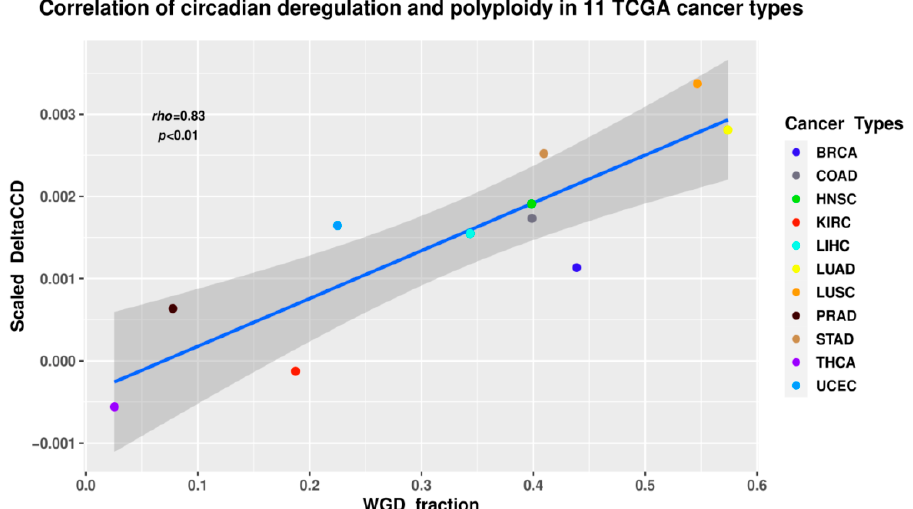
Figure 10. The DeltaCCD (clock correlation distance) coefficient (calculated using the method developed by [55]) describes the extent to which the core clock gene coexpression network diverges from its normal state. The tumor types with a higher prevalence of polyploid (WGD+) samples also demonstrate more profound CC deregulation (Spearman’s rho = 0.83, p < 0.01) and high disease aggressiveness: BRCA—breast carcinoma; COAD—colon adenocarcinoma; HNSC—head and neck squamous cell carcinoma; KIRC—kidney renal cell carcinoma; LIHC—liver hepatocellular carcinoma; LUAD—lung adenocarcinoma; LUSC—lung squamous cell carcinoma; PRAD—pros ‐ tate adenocarcinoma; STAD—gastric adenocarcinoma; THCA—thyroid carcinoma; UCEC—uterine corpus endometrial carcinoma (Note: This figure was originally published under CC-BY license in [32]).